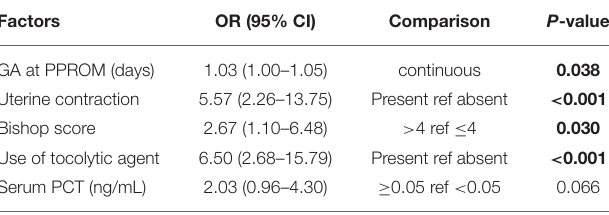
TABLE 2 | Binary logistic regression models of short latency period.